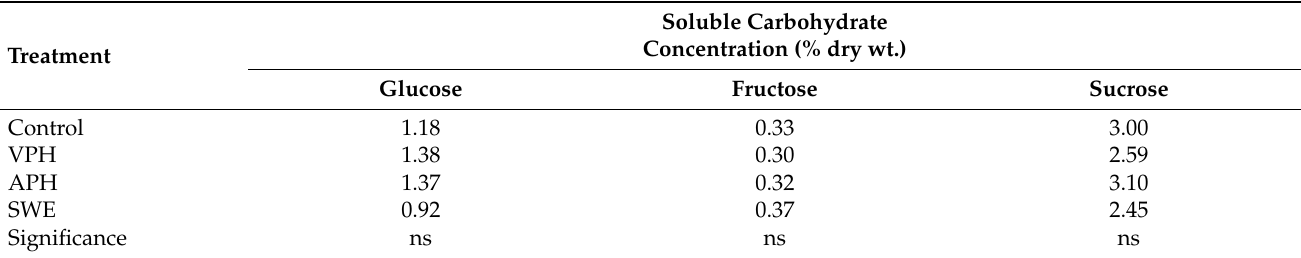
Table 4. Effect of biostimulant treatments on glucose, fructose, and sucrose concentration of chicory roots in the greenhouse trial.